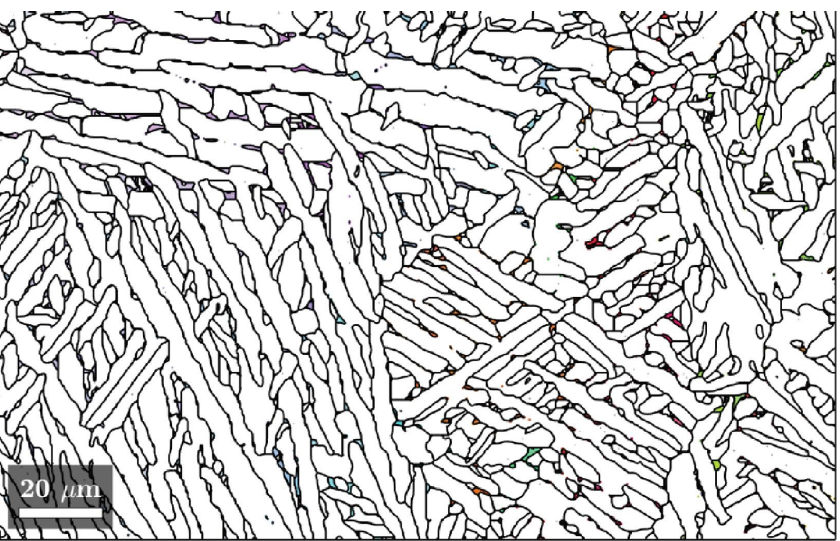
Figure 2: A microstructure of DMLS Ti6Al4V (ELI) was exposed to duplex annealing at 940 ° C for 2h, then furnace cooled, followed by soaking at 750 ° C for 2h, and then furnace cooled. Te coloured small portions of the micrograph show the retained β -phase along the α -lath grain